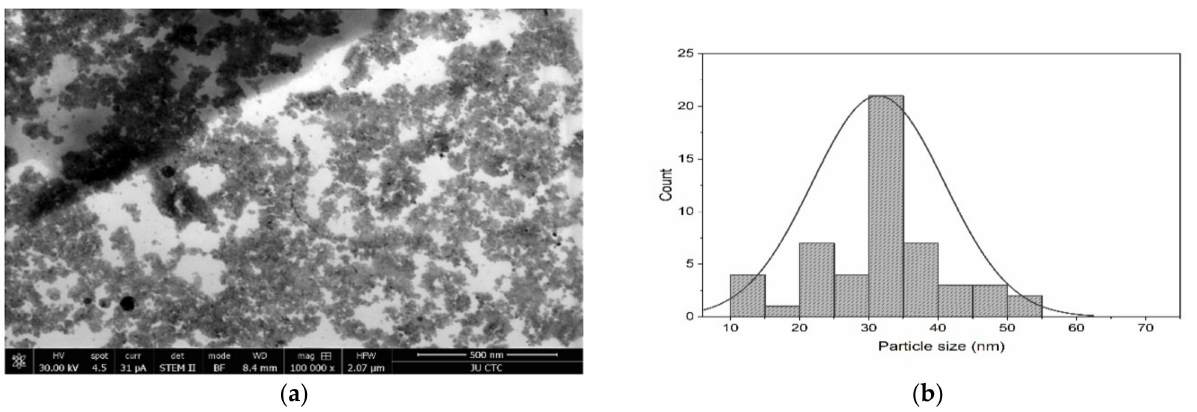
Figure 2. ( a ) FESEM images of the Cu 0.5 Zn 0.5 Fe 2 O 4 -NP; and ( b ) particle size distribution with a Gaussian fit average particle size (nm) = 31.2135 ± 0.23159.